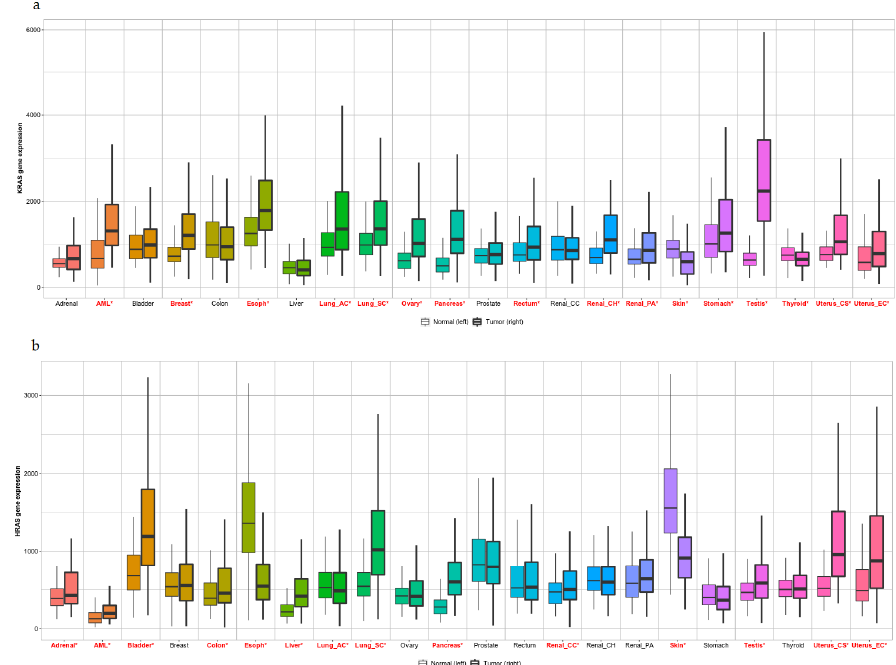
Figure 1. KRAS ( a ) and HRAS ( b ) pan-cancer expression (significant differences are marked with red).